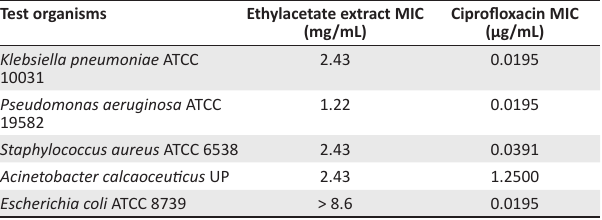
TABLE 2: Minimum inhibitory concentration of ethylacetate fraction of Adansonia digitata extract on the bacterial isolates. Test organisms